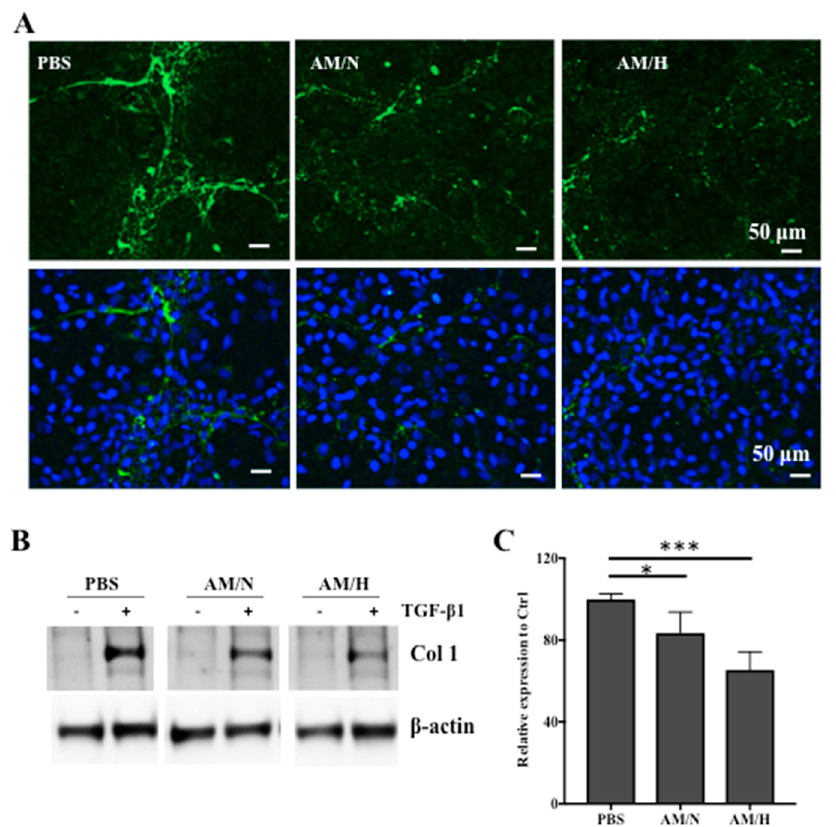
Figure 4. Effect of AM exosomes on the protein expression of type I collagen (Col1). Non-activated LX-2 cells were cultured in the presence (AM/N or AM/H) or absence (PBS) of exosomes for 5 days. Cells were fixed and immunostained with antibody against Col1 (( A ) upper panel) and merged with Hoechst dye staining (( A ) lower panel). Representative images are shown ( A ). Scale bar = 50 µ m. LX-2 cells were cultured in the presence (AM/N or AM/H) or absence (PBS) of exosomes for 2 days. The expression of Col1 in non-activated ( − ) and activated (+) LX-2 cells were analyzed by Western blotting using antibodies against Col1 and β -actin. Representative blots are shown ( B ). The relative band intensity of Col1 in the presence of TGF- β 1 was quantified using Image J software ( C ). Data are presented as mean ± SD ( n = 4). * p < 0.05 *** p < 0.005.